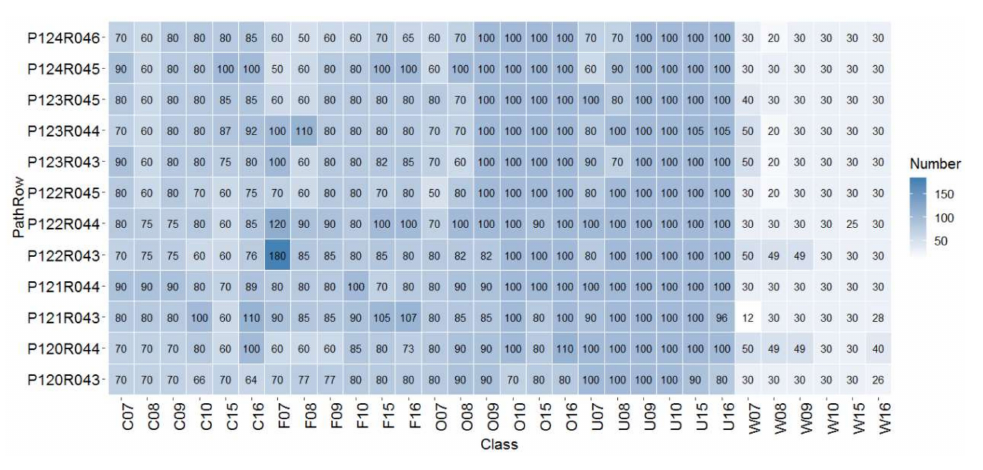
Figure 3. Numbers of regions of interest (ROIs; C07: 2007 cropland ROIs, F07: 2007 forest ROIs, O07: 2007 other types ROIs, U07: 2007 urban ROIs, W07: 2007 water ROIs ,..., C16: 2016 cropland ROIs, F16: 2016 forest ROIs, O16: 2016 other types ROIs, U16: 2016 urban ROIs, W16: 2016 water ROIs) used for training and validation of classification algorithms were collected by 12 Paths/Rows on Google